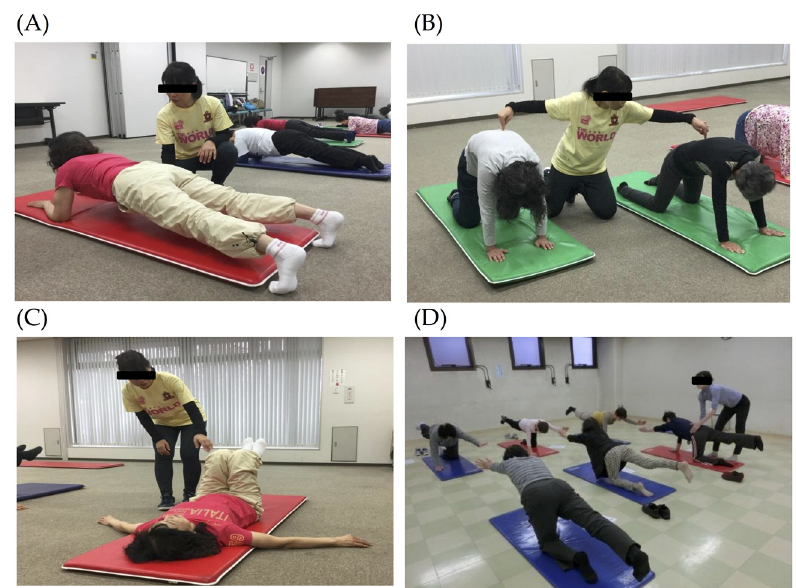
Figure 1. Exercises during trunk muscle training. ( A ) Arching–swaying while standing on all fours, ( B ) plank, ( C ) lying pelvic rotation, and ( D ) diagonal lifting while standing on all fours.